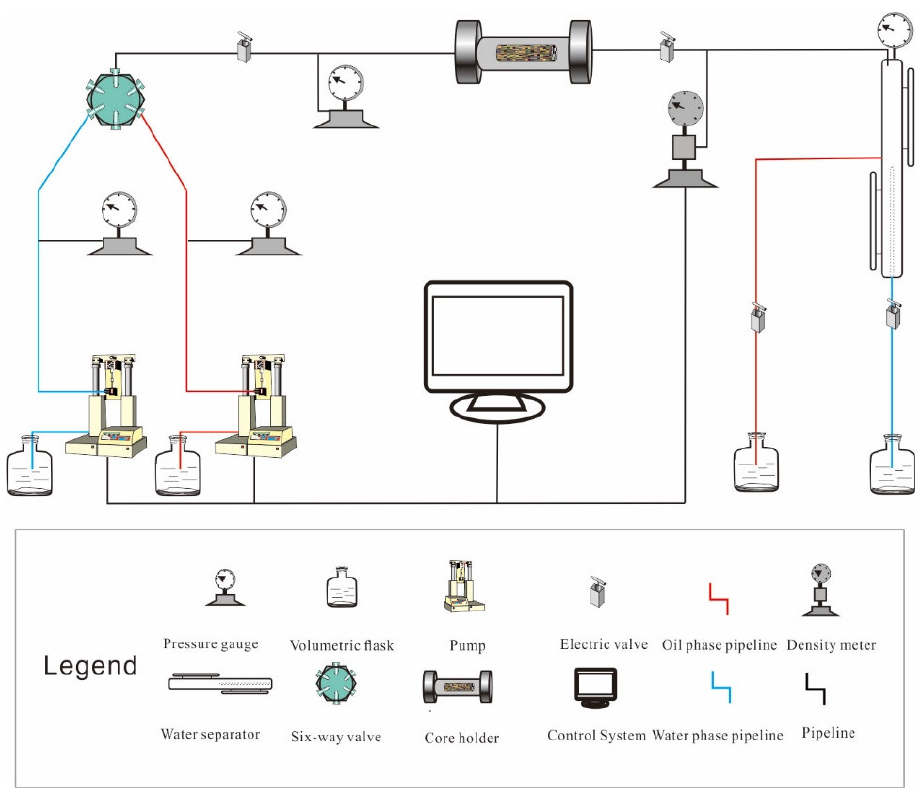
Figure 2. Schematic representation of the experimental apparatus of the relative permeability meas- urement.